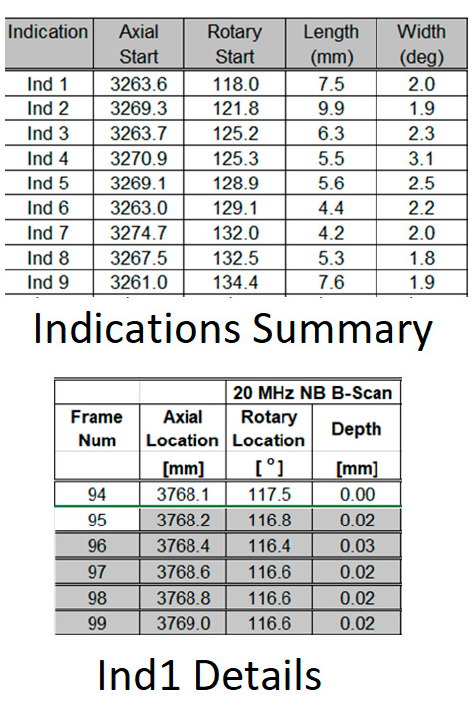
Figure 5. Flaw indication reporting sample (results report from one stream).